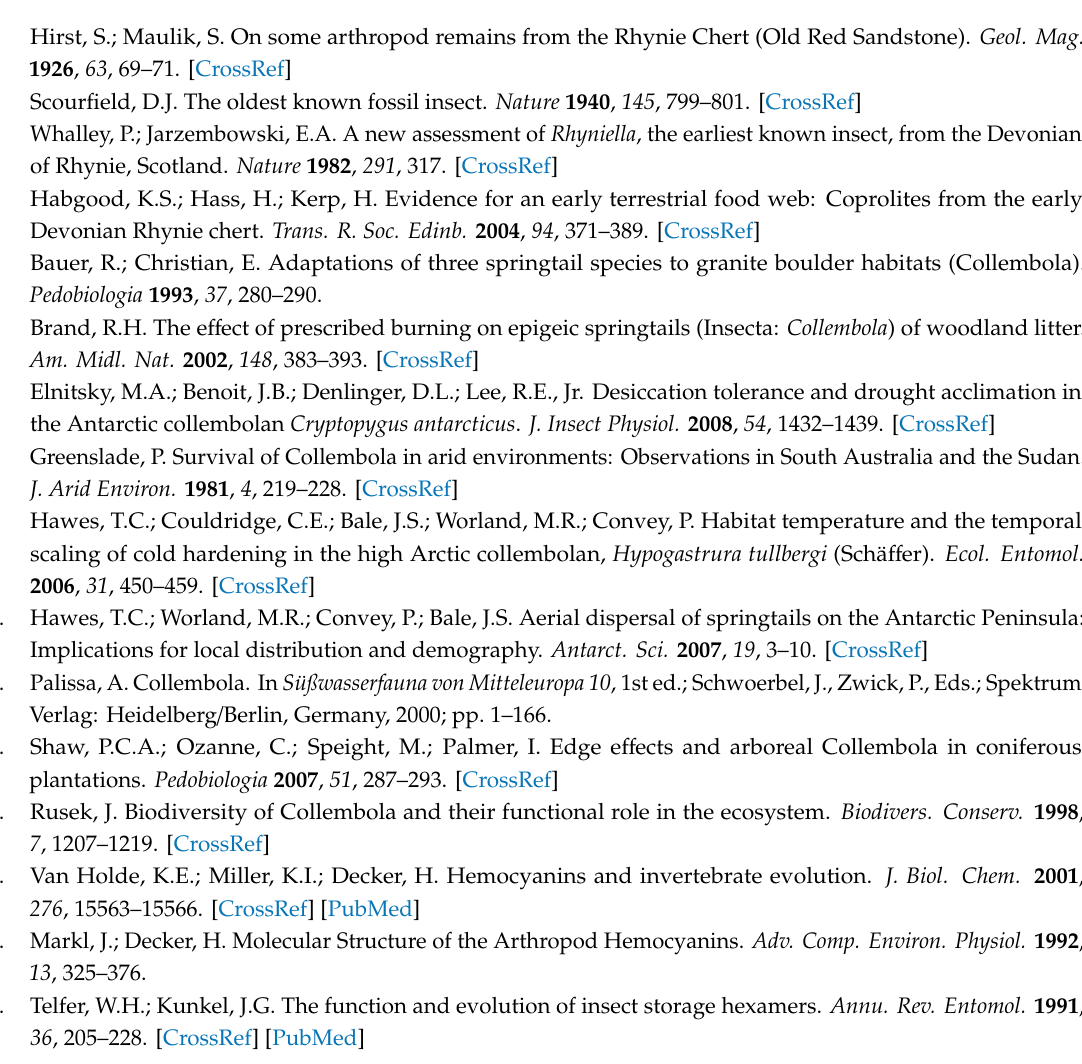
Figure S1: Absorbance of size exclusion gel chromatography and di ff raction of the Multi Angle Laser Light scattering (MALLS) and SDS-PAGE of the collected Peaks, Figure S2: Protein identification of the 72 and 77 kDa bands out of the SDS-PAGE of Sinella curviseta hemolymph (Figure 2) by mass spectroscopy, Figure S3: MSMS spectrum masses of the Protein identification of S.cu hemocyanin by mass spectroscopy, Figure S4: UV / Vis absorption spectrum of Sinella curviseta hemolymph. Data S6: Detailed data of the performed protein identification as compressed data incl.FASTA file of the databases which were used for the protein identification by mass spectroscopy. Uniprot Collembola, Manduca secxta , Carausius morosus and insecticyanin database (downloaded 15th October 2015, 2315